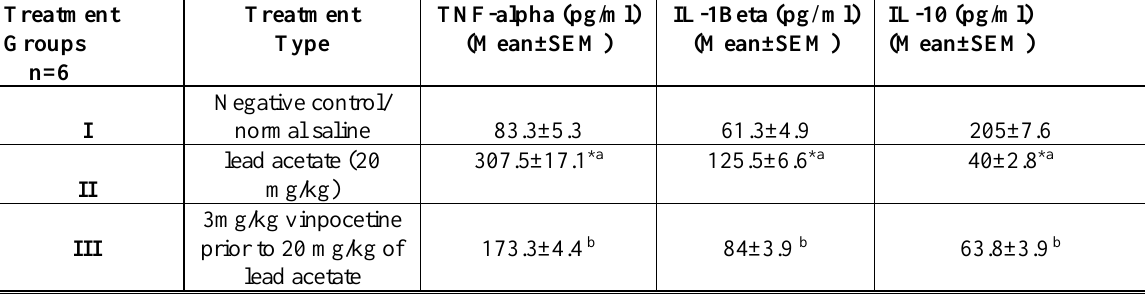
Table 1. Effect of vinpocetine on TNF-α, IL-1β, and IL-10 levels in brain tissue homogenate of rats after IP injection of lead acetate Treatment Groups